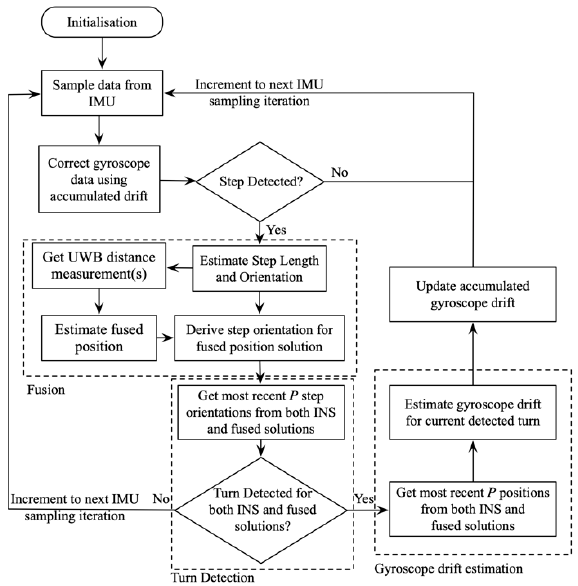
Figure 3. Processing flow of the proposed UWB fusion IPSs (FIPSs).